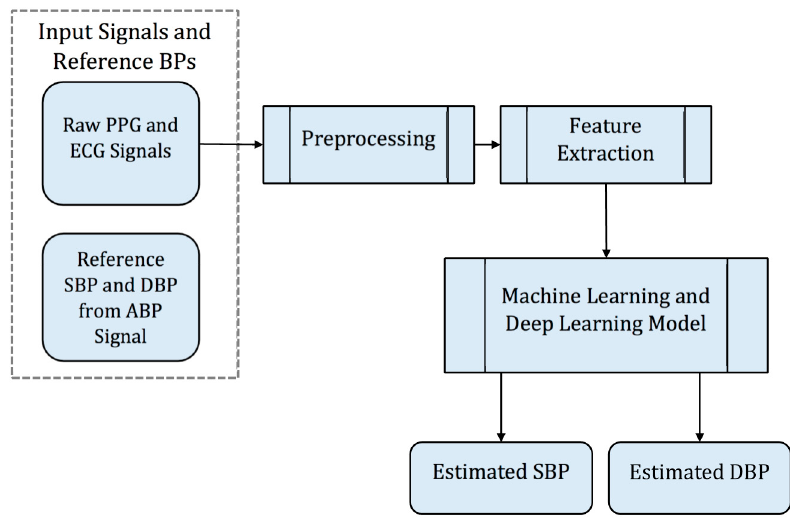
Figure 6. Flow diagram of the proposed methodology.